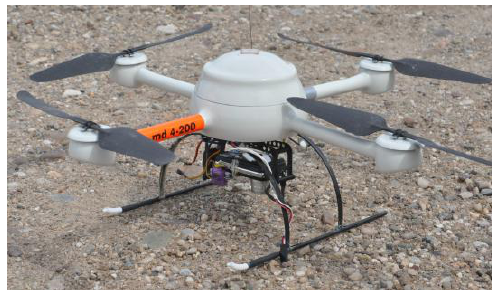
Figure 1. The md4-200 with the digital camera Pentax Optio A40